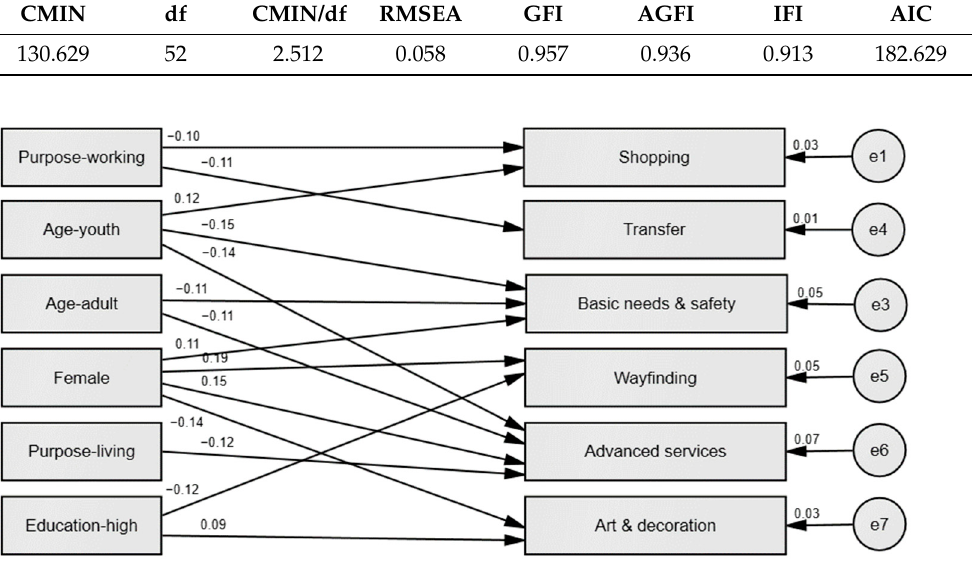
Figure 4. Structure of the model.